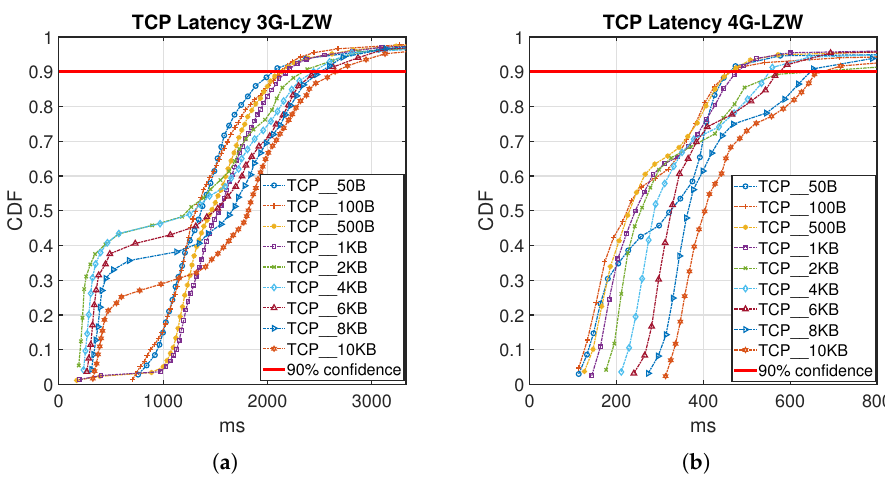
Figure 10. CDF plot for different data packet size both for 3G ( a ) and 4G ( b ) using LZW